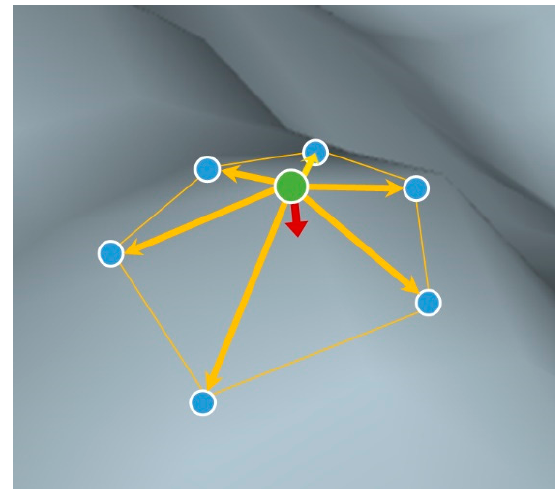
Figure 2. A sketch of surface normal and surface mean curvature (red arrow), calculated as average of unit vectors (yellow arrow) pointing from center point (green dot) to neighboring points (blue dots).